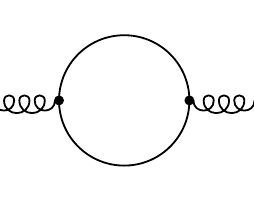
Figure 3: The loop contribution from the N α